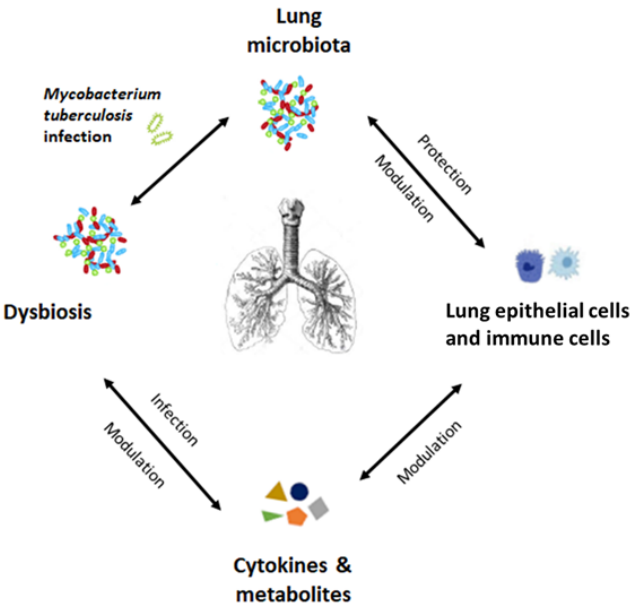
Figure 2. Hypothesized role of the lung microbiota in the pathogenesis of